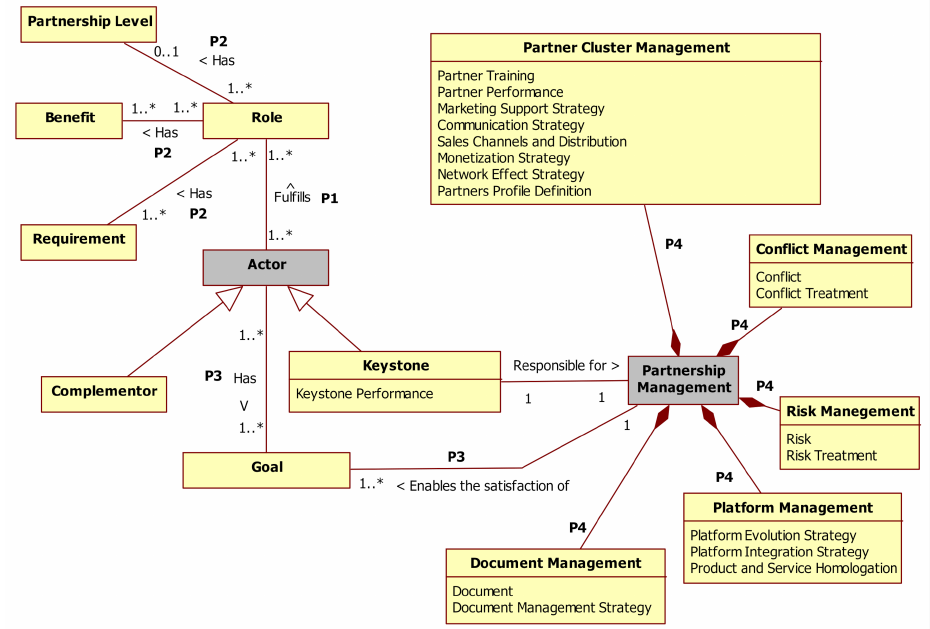
Figure 6. Partnership